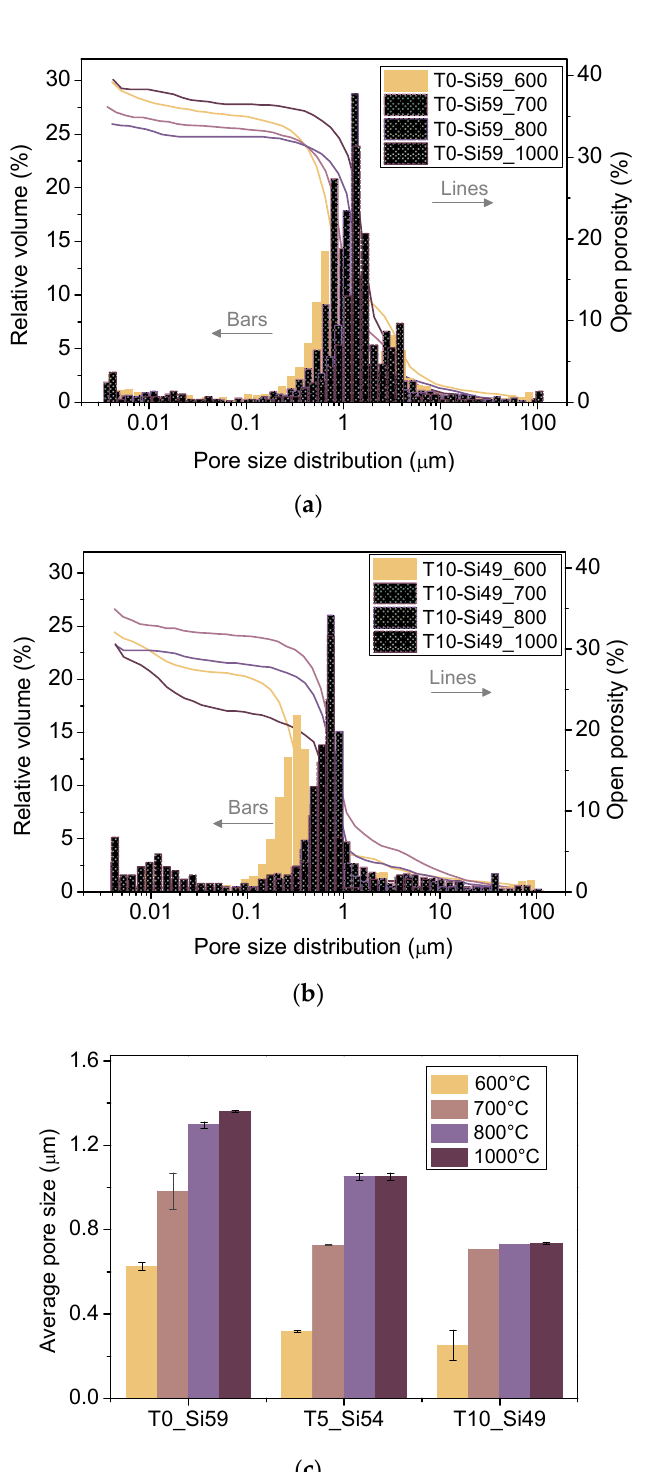
Figure 4. Pore size distribution, open porosity and average pore size for the tapes: ( a ) T0-Si59 and ( b ) T10_Si49 pyrolyzed at 600–1000 °C. ( c ) The average pore size for all of the samples pyrolyzed at 600–1000 °C.